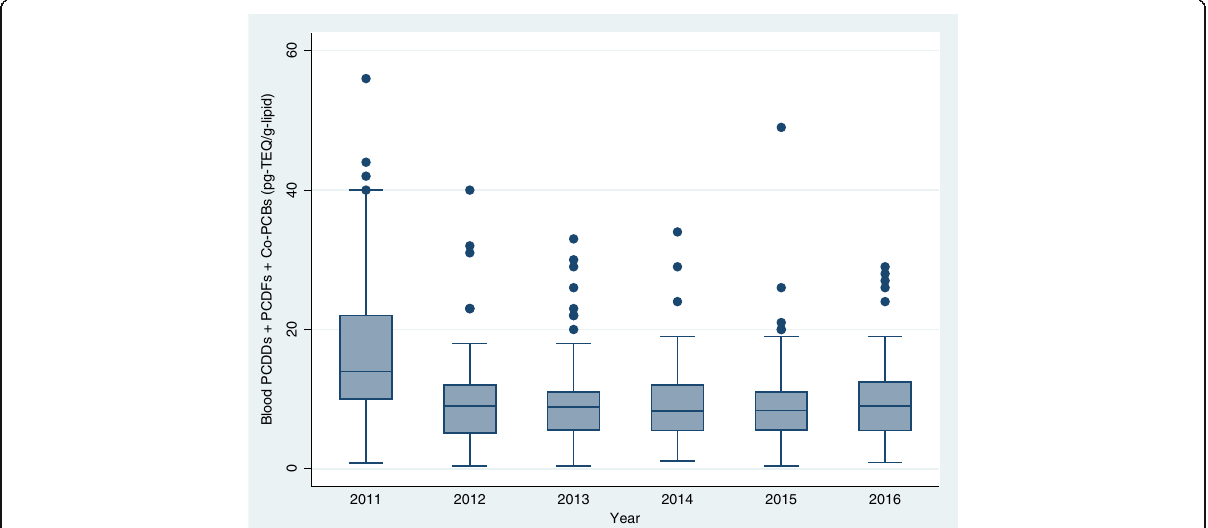
Fig. 2 (Showing whiskers). Box plot (median, interquartile range and range) of total TEQ in the blood (in pg TEQ/g lipid) by survey year of the ‘ survey on the exposure to dioxins and other chemical compounds in humans, ’ 2011 to 2016. The median (range) of total TEQ by survey year was 14.0 (0.8 – 56.0), 9.0 (0.4 – 40.0), 8.9 (0.4 – 33.0), 8.3 (1.1 – 34.0), 8.4 (0.3 – 49.0) and 9.0 (0.9 – 29) in 2011, 2012, 2013, 2014, 2015 and 2016, respectively. The Kruskal-Wallis test ( p < 0.001) was used to compare the differences in total TEQ in blood across the survey years. Definition of abbreviations: PCDDs, polychlorinated dibenzo-dioxins; PCDFs, polychlorinated dibenzofurans; Co-PCBs, coplanar polychlorinated biphenyls; TEQ,